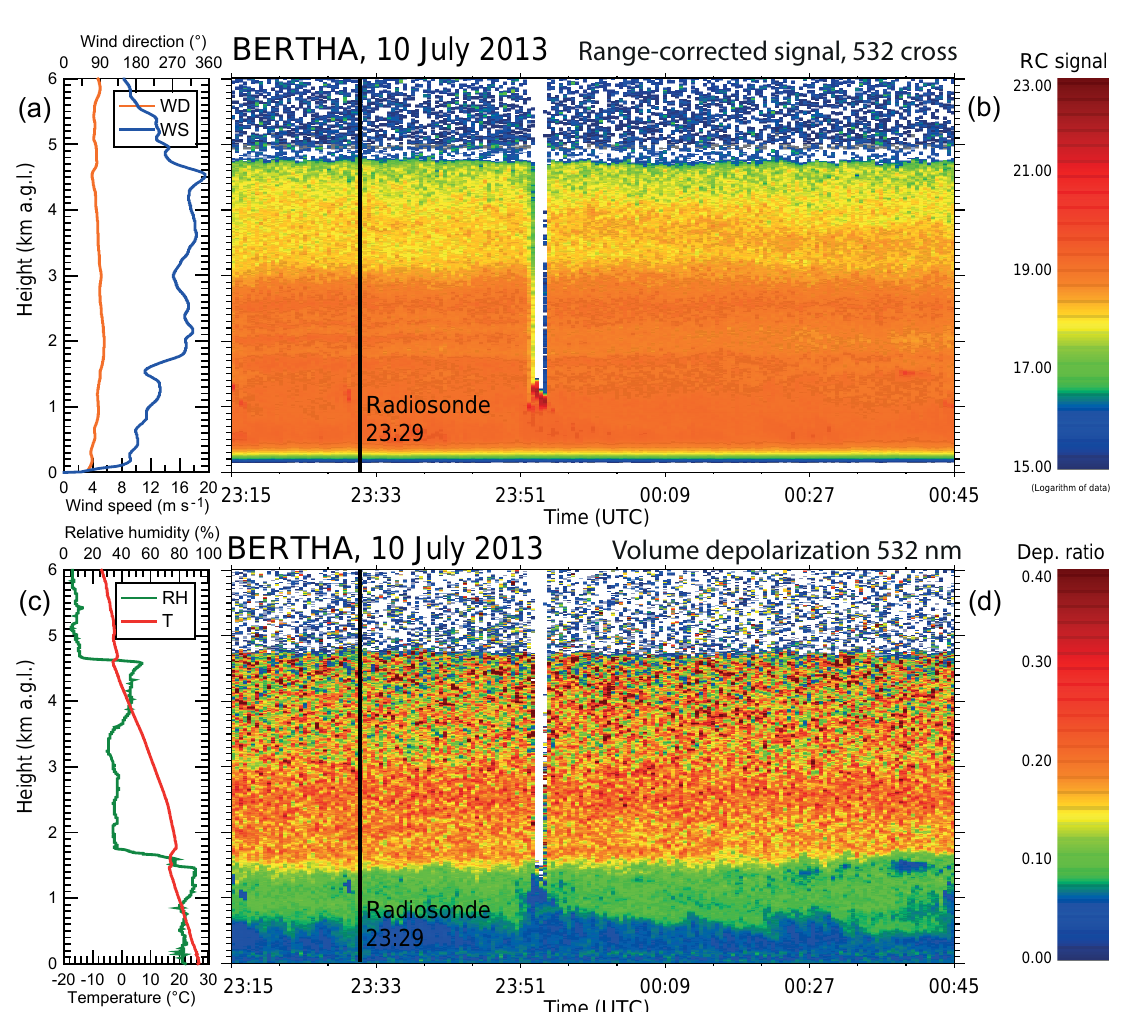
Figure 2. Saharan air layer (from 1.5 to 4.7km height above ground level) above the marine boundary layer. Panel (b) shows the range- corrected cross-polarized 532nm backscatter signal with temporal and vertical resolutions of 30s and 7.5m, respectively. Panel (d) shows the 532nm volume linear depolarization ratio. The lidar observation was performed on 10 July 2013, 19:15–20:45LT. A radiosonde was launched at 19:29LT (indicated by black vertical lines). The radiosonde profiles of wind speed (WS) and wind direction (WD) are shown in panel (a) , the profiles of relative humidity (RH) and temperature ( T ) in panel (c)